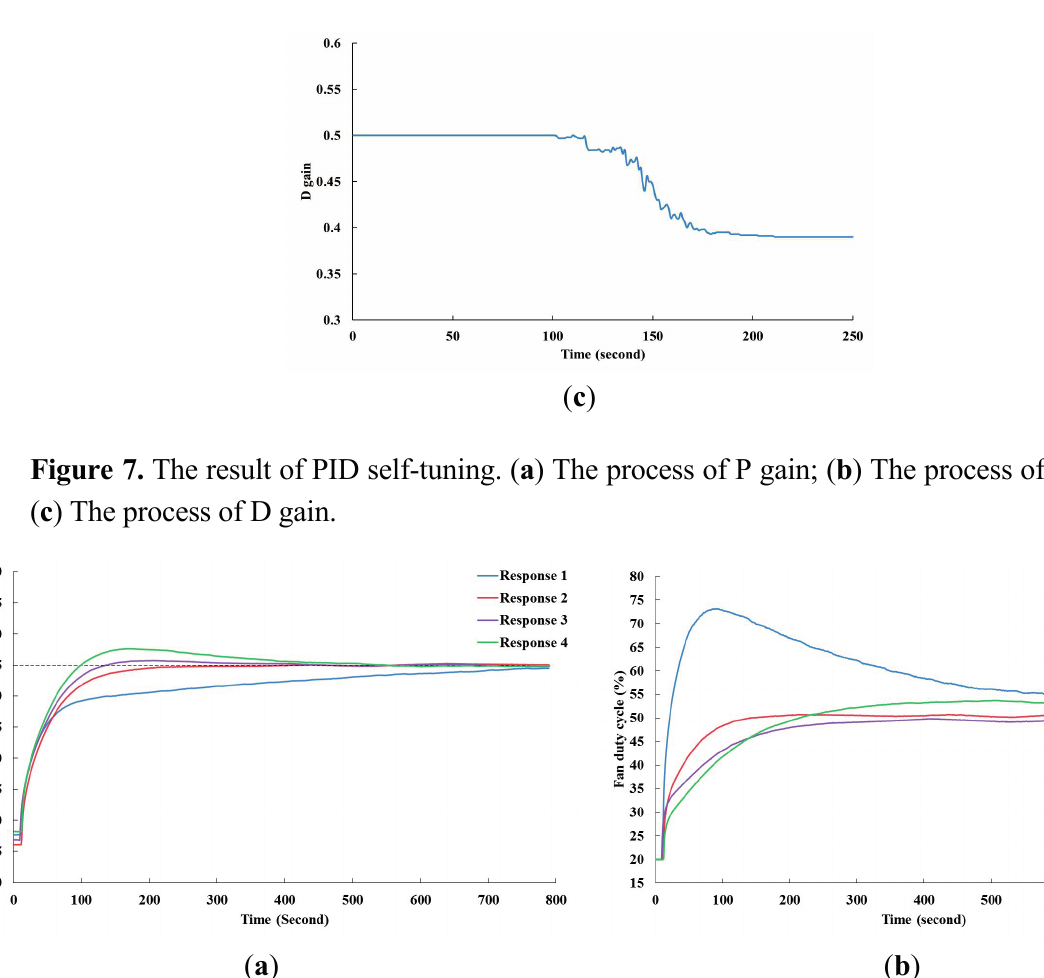
Figure 8. Control results of various PID controllers for CPU1. ( a ) The temperature responses of CPU1 by the PID controller; ( b ) The control efforts of Fans 3 and 4 by the PID